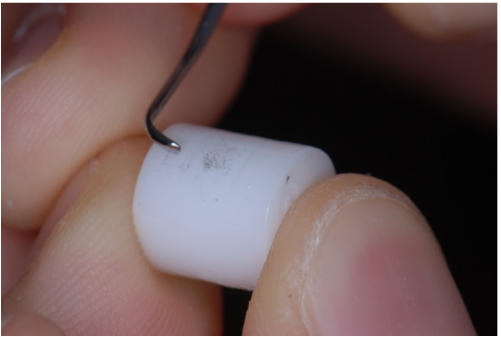
Figure 2. Examples of curettes